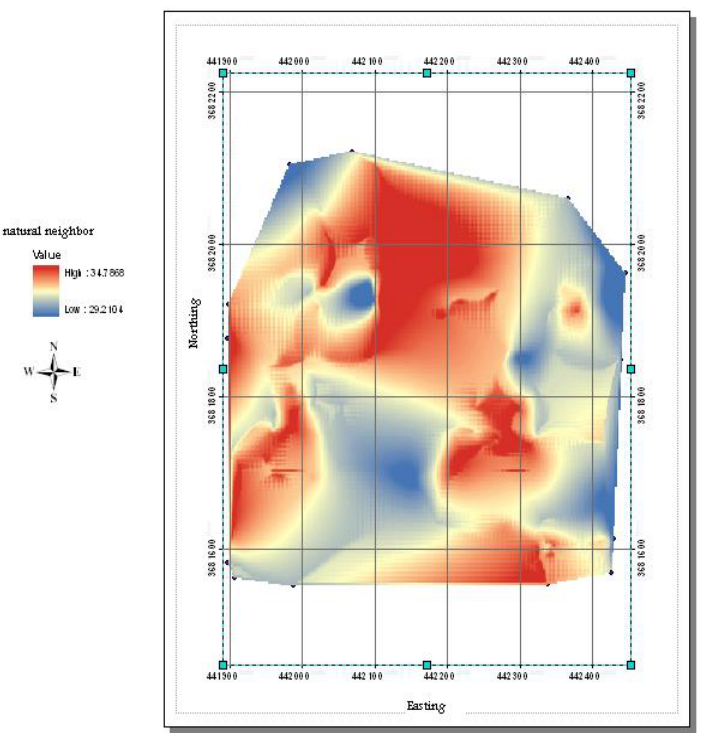
Fig. 7: The raster DEM of the ground level slice, using the natural neighbor method.